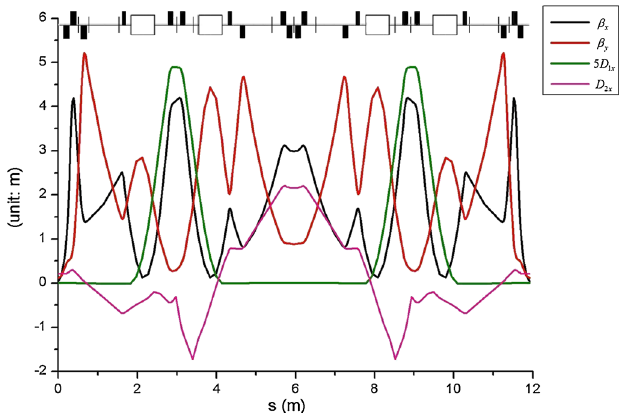
FIG. 2. (Color) Twiss functions of the ring lattice. The beta function at the IP is (cid:6) x ¼ 0 : 049 m and (cid:6) y ¼ 0 : 115 m . The first order dispersion at the IP is zero, while the second order ¼ 0 : 21 m , which is relatively small. We dispersion is D 2 x strengthened the quadrupoles to achieve higher betatron phase advance, which reduces the average value of the H x function thus decreasing the IBS growth